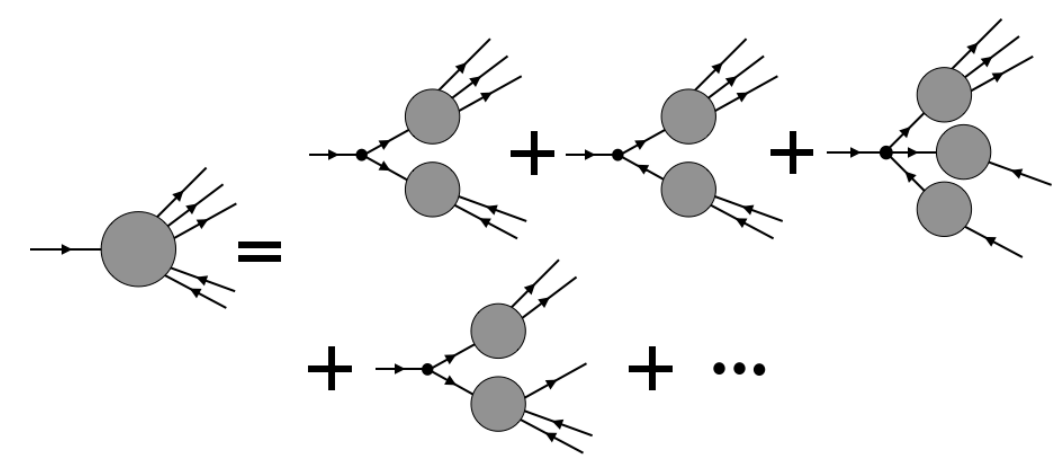
Figure 3 . Recursion scheme for the amplitudes, drawn here for p =